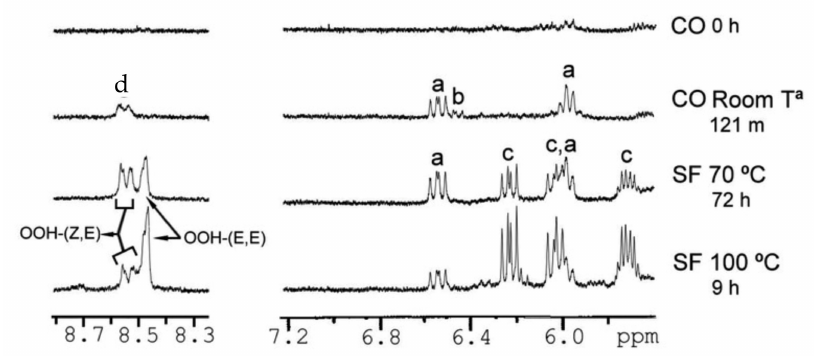
Figure 25. Selected regions of 1 H-NMR spectra (400 MHz) of primary oxidation compounds formed in corn oil (CO), nonoxidized (0 h) and stored at room temperature in closed receptacles for 121 months; sunflower oil (SF) subjected (10 g oil, Petri dish) to thermal oxidation at 70 ◦ C for 72 h and at 100 ◦ C for 9 h. Letter abbreviations have as follows: ( a ), α -hydroperoxy ( Z , E )-conjugated double bonds; ( b ), hydroxy ( Z , E )-conjugated double bonds; ( c ), hydroperoxy ( E , E )-conjugated double bonds;